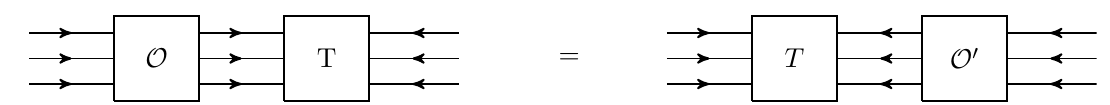
Figure 6. Illustration of the operator pushing operation. An operator O acting on a subset of size n of a perfect tensor with 2 n legs is equivalent to an operator O ′ = T † O T acting on the